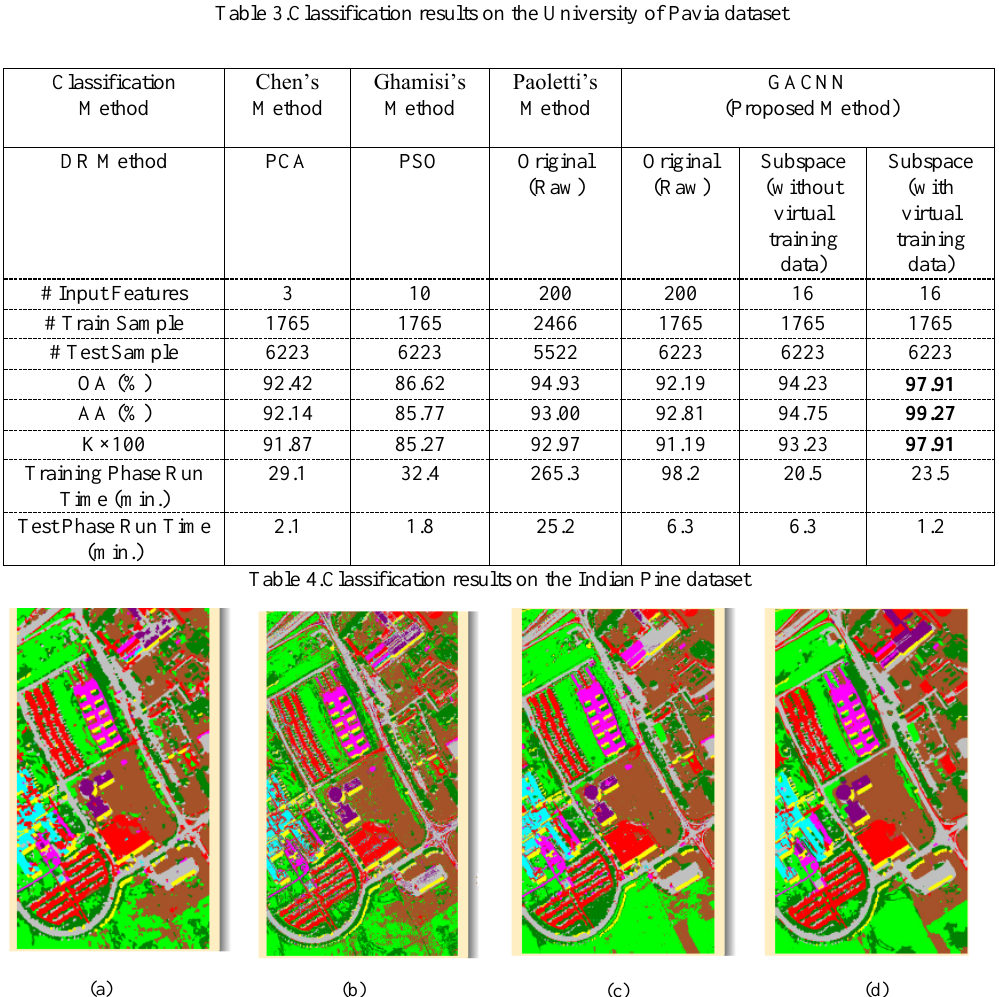
Figure 5. University of Pavia. (a)– (d) Classification maps for different classifiers: (a) Chen’s Method with OA=97.21%, (b) Ghamisi’s Method with OA=90.23%, (c) Paoletti’s Method with OA=93.18% (d) GACNN (proposed) with